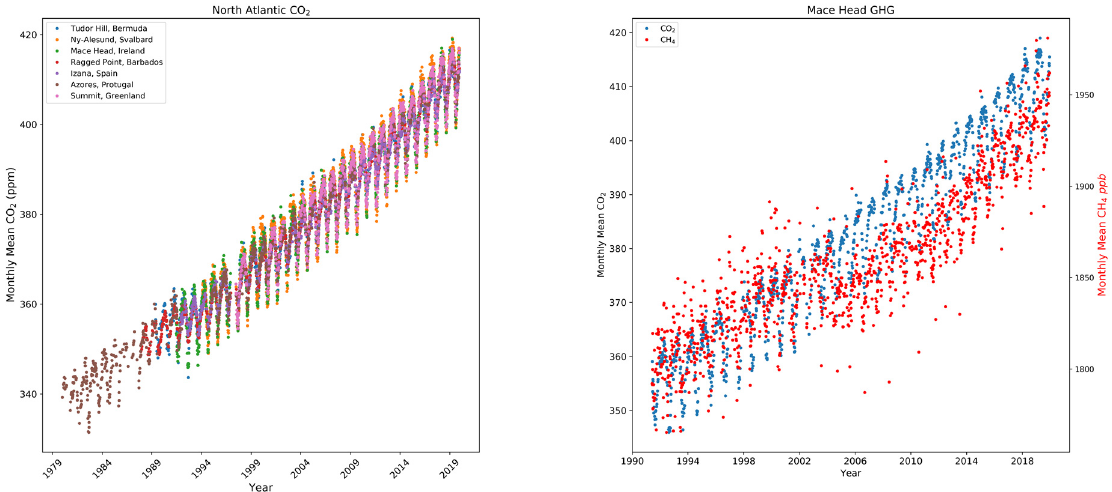
Figure 2. ( Left ) CO 2 trends from 1979 onwards taken from sites surrounding the Atlantic Ocean. Data taken from the Carbon Cycle Greenhouse Gas cooperative air sampling network, which began in Colorado, 1967 and resampled to monthly mean values. The data here are sampled in each station using flask containers and sent back to NOAA’s Global Monitoring Division. ( Right ) CO 2 and CH 4 record taken at Mace Head, Ireland. The data are filtered to display only samples representative of a remote, well-mixed troposphere and data are available from the Global Monitoring Laboratory of the National Oceanic and Atmospheric Administration. Data available at the NOAA Global Monitoring Laboratory .